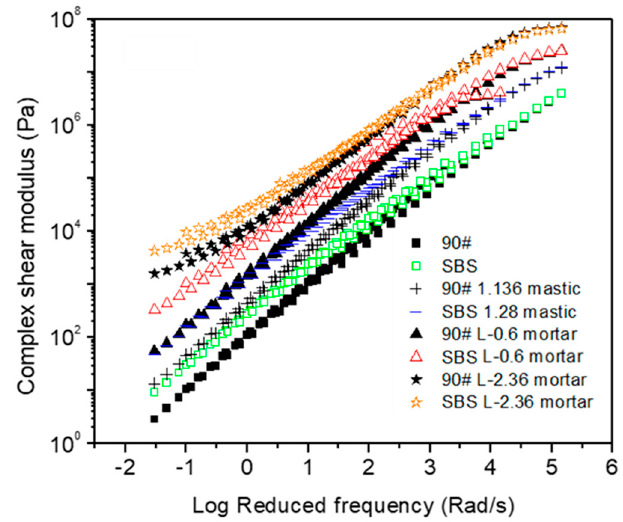
Figure 7. Complex modulus comparison between 90# neat asphalt and SBS modified asphalt based materials at a reference temperature of 60 °C.